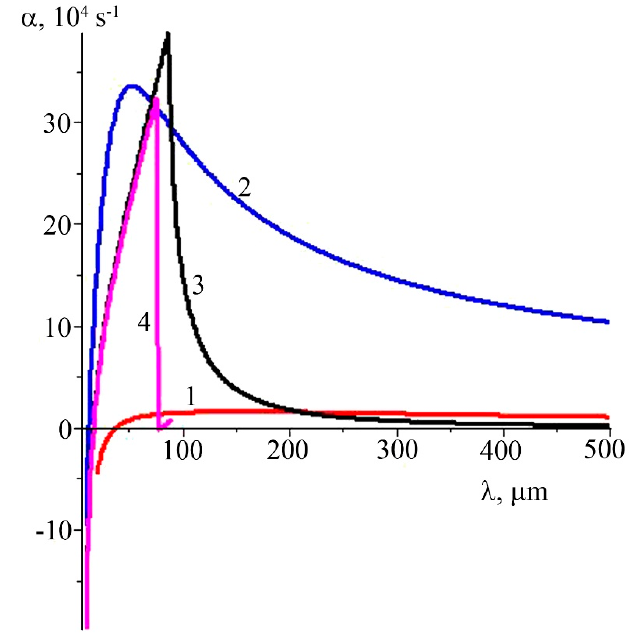
Figure 4. A growth rate characteristic of perturbations on the plasma–silumin melt interface found when solving the Equation (11): ( 1 ) ignoring thermoelectric and evaporation and capillary effects, ( 2 ) including the thermoelectric effect only, ( 3 ) with regard to thermal and evaporation and capillary instabilities, ( 4 ) involving thermal, evaporation and capillarity instabilities and the thermoelectric effect.